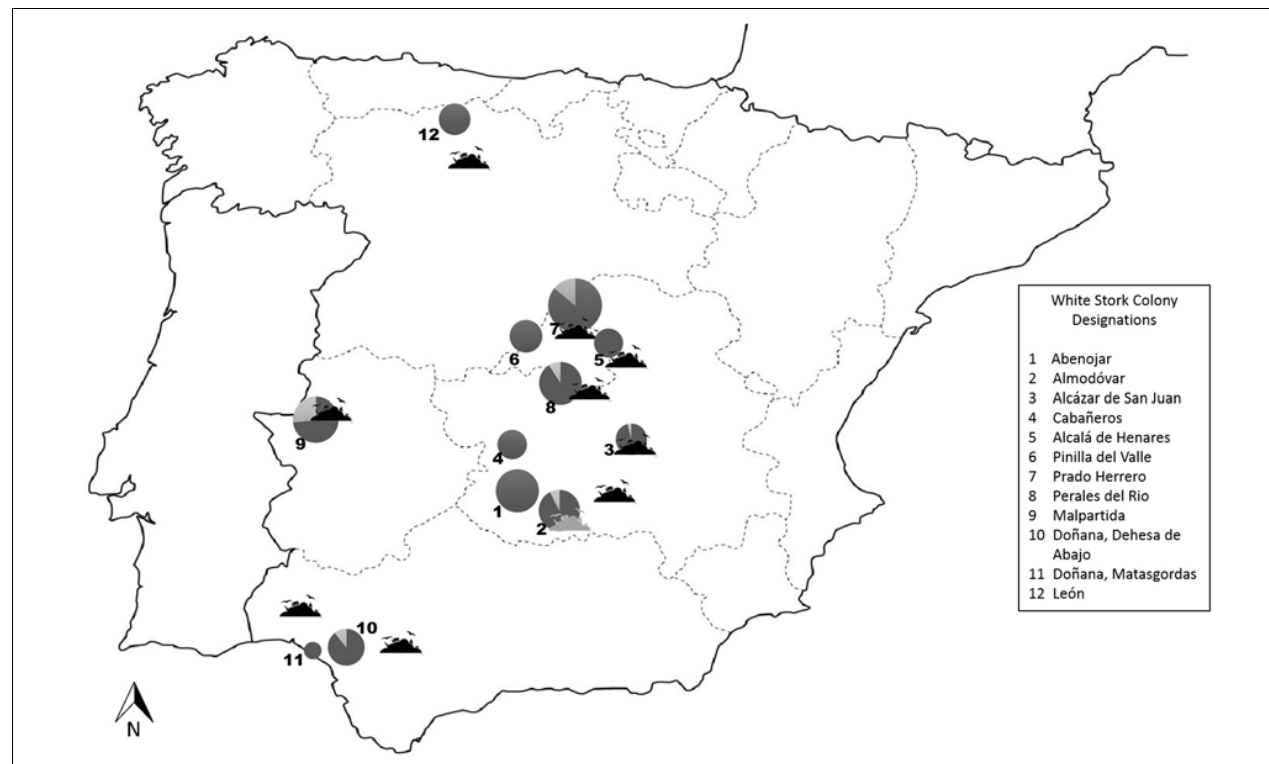
FIGURE 1 | Distribution of studied colonies and the closest solid urban waste landfills in Spain. The size of the circles reflect sample size and the lighter shaded areas reflect CR E. coli prevalence. The shaded solid urban waste landfill silhouette shows a landfill that was sealed in 2005.